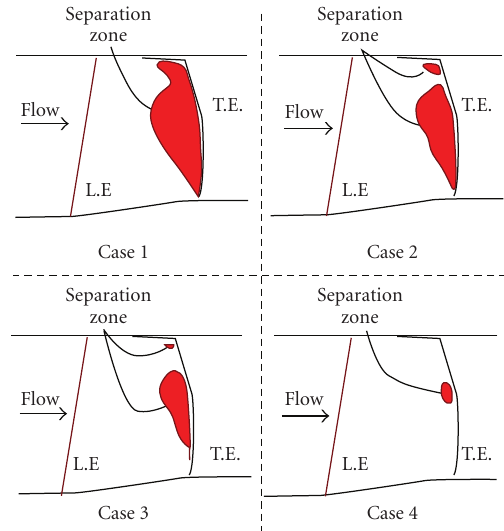
Figure 13: Evolution of the separated flow region (on the suction side) all along the span for an actuator located at position